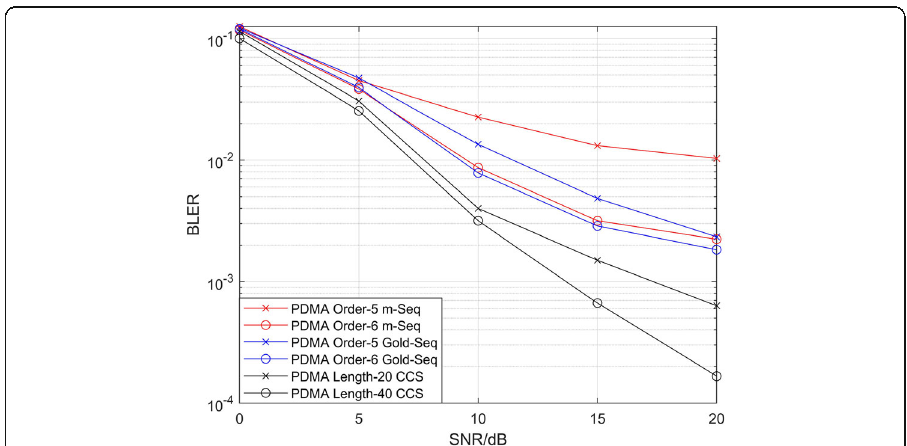
Fig. 12 Performance comparison of three spread spectrum sequences under dynamic power allocation. The comparison of dynamic power allocation performance of 5-order 6-order m-sequence, 5-order 6-order Gold sequence, and CCS with length of 20 and 40. The dimension of pattern matrix is 2 (cid:5)